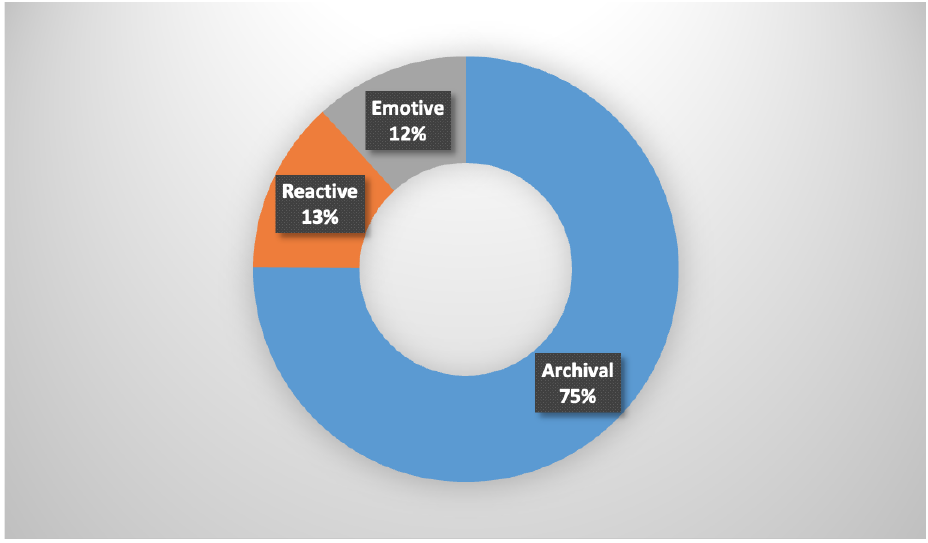
Chart 3: Functions of the Common